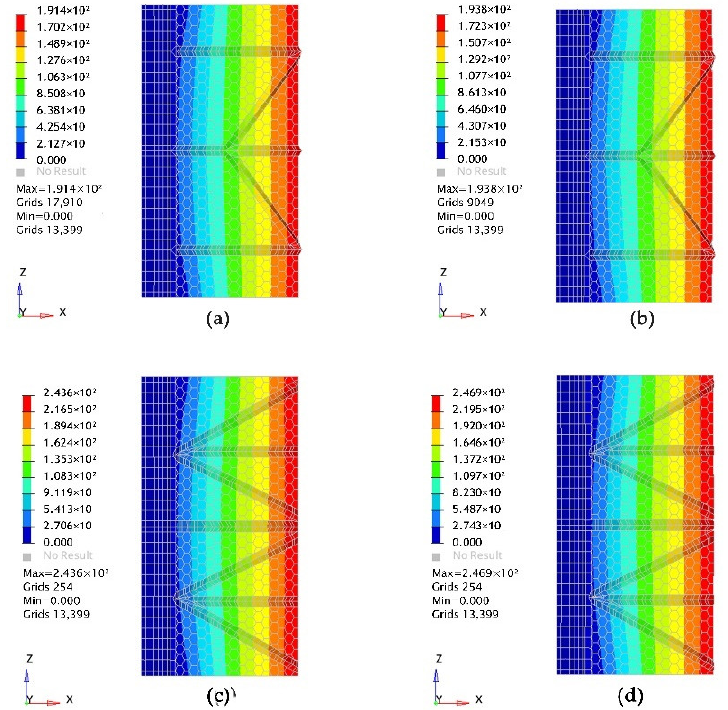
Figure 26. ( a ) Linear combined displacement analysis of carport I model under the G k + 0.85 Q S + Q W load; ( b ) Nonlinear combined displacement analysis of carport I model under the G k + 0.85 Q S + Q W load; ( c ) Linear combined displacement analysis of carport II model under the G k + 0.85 Q S + Q W load; ( d ) Nonlinear combined displacement analysis of carport II model under the G k + 0.85 Q S + Q W load.